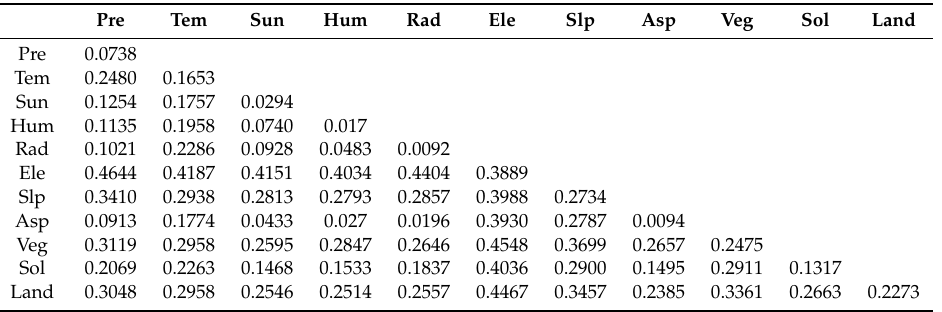
Table 6. The interaction between